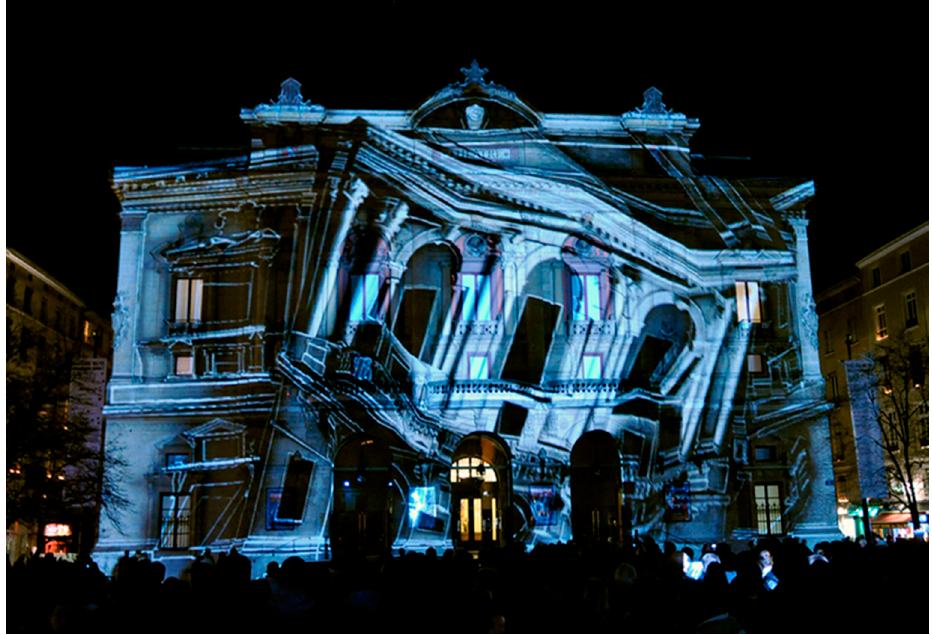
Figure 1. The floating façade of Lyon “Celestine” Opera, during the 2010 “Fete des Lumières”, realized by 1024 Architecture